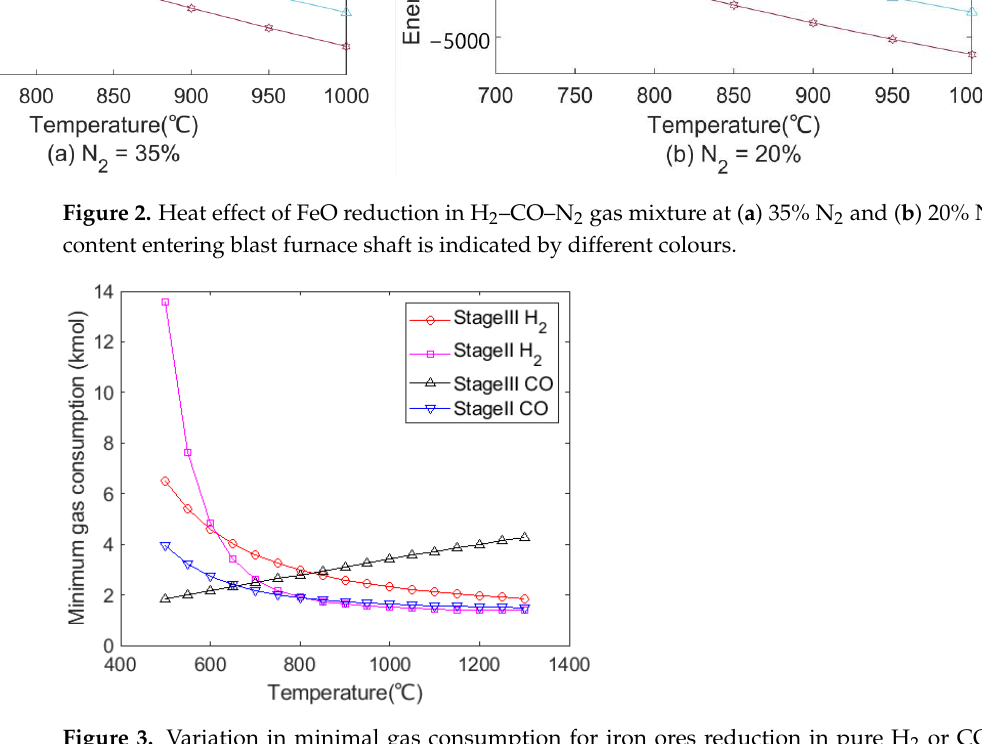
Figure 3. Variation in minimal gas consumption for iron ores reduction in pure H 2 or CO with temperature.